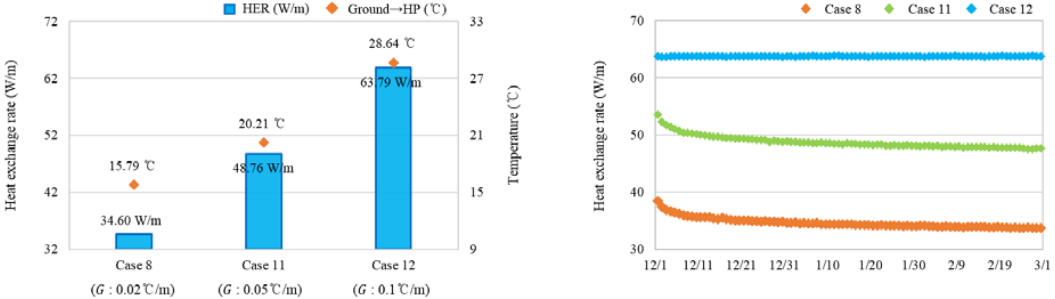
Figure 9. EWT and HER according to the geothermal gradient.